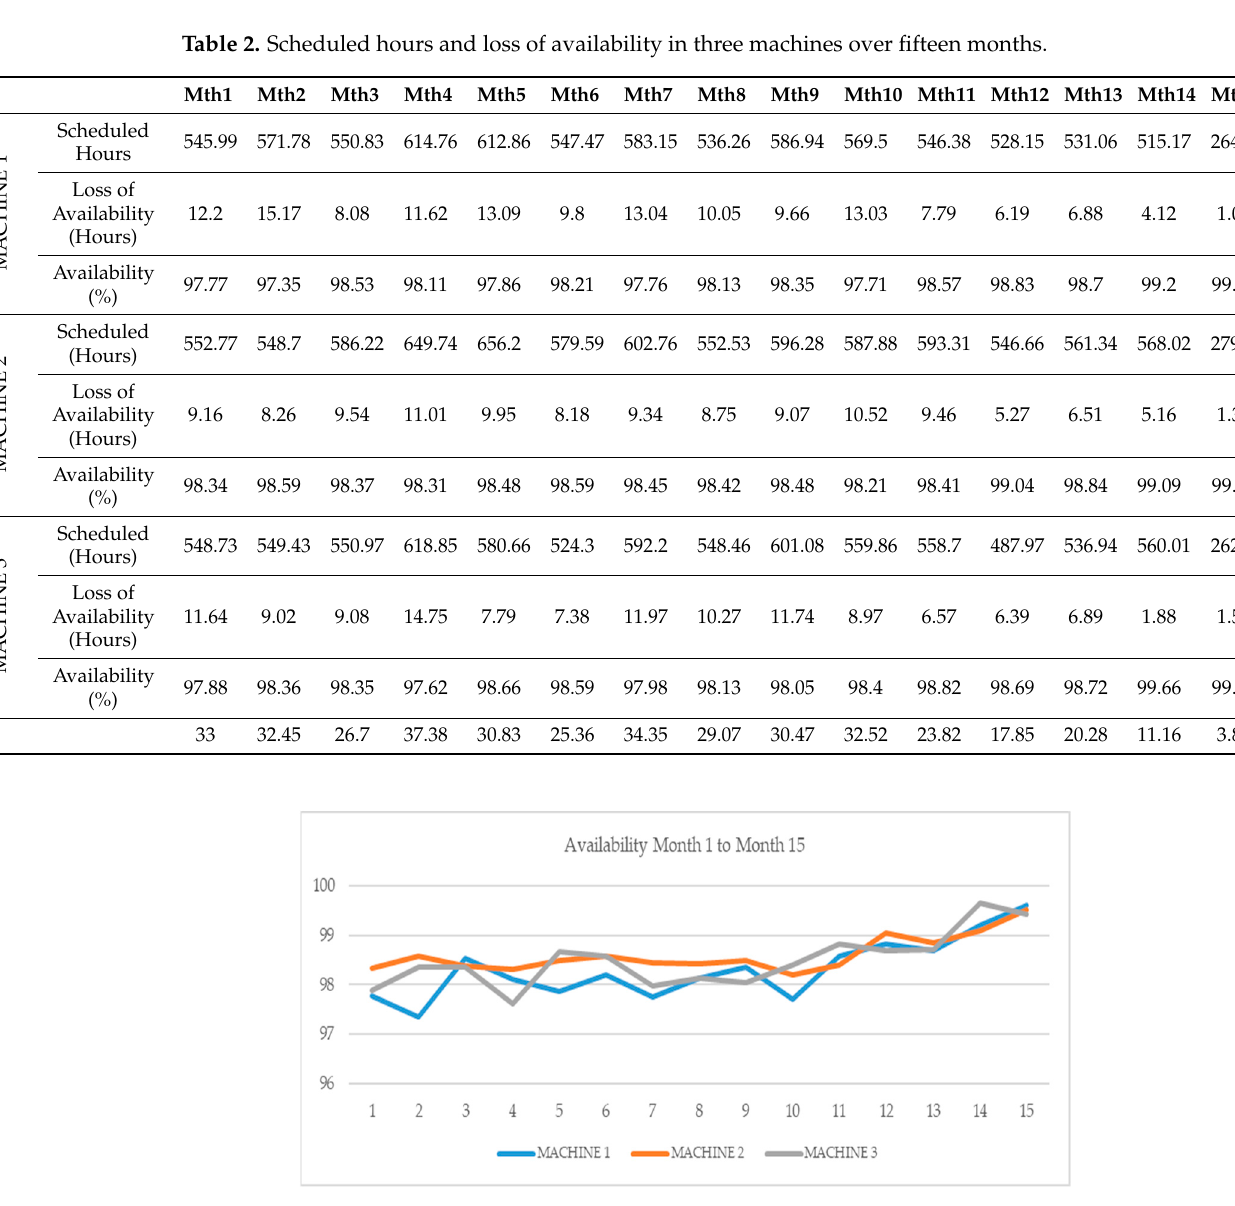
Table 2. Scheduled hours and loss of availability in three machines over fifteen months.